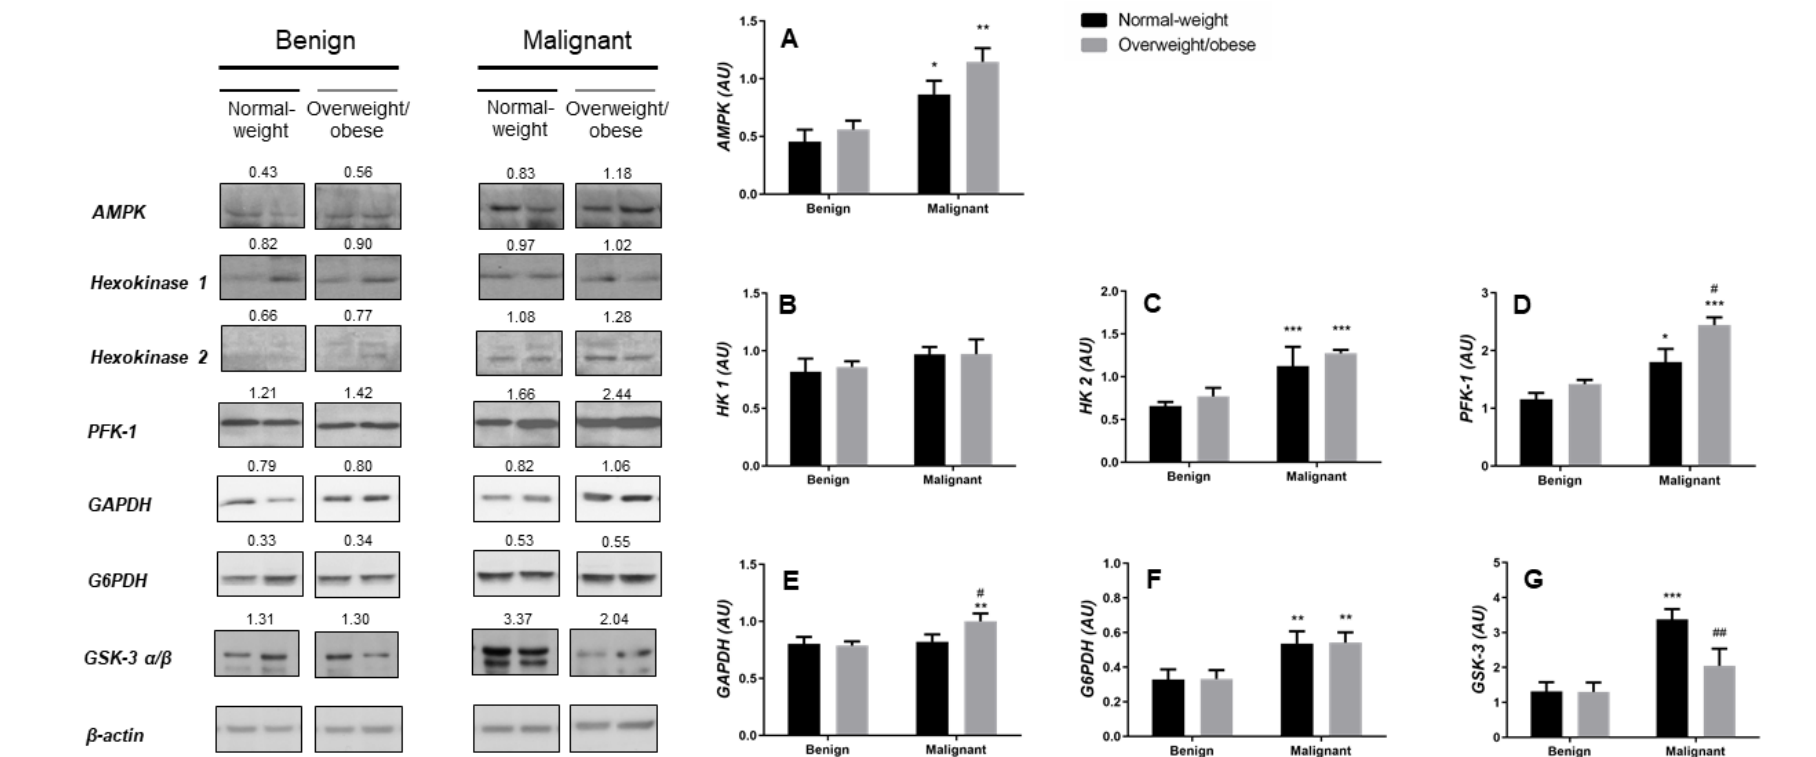
Figure 1. Breast cancer changes in glucose metabolic pathways and their relationship to obesity. Protein expression of 5′-AMP-activated protein kinase (AMPK, A ), hexokinase 1 (HK 1, B ), hexokinase 2 (HK 2, C ), phosphofructokinase (PFK-1, D ), glyceraldehyde-3-phosphate dehydrogenase (GAPDH, E ), glucose-6-phosphate 1-dehydrogenase (G6PDH, F ) and glycogen synthase kinase-3 (GSK-3 α / β , G ) in benign and malignant breast tumor tissue of normal-weight (black) and overweight/obese (gray) women. The protein content is normalized to β -actin levels and expressed in arbitrary units (AU); mean values of densitometric analysis for each group are shown above respective bands. Two representative band images cut from the same blot are shown for each group ( n = 9); each band is representative of three pooled samples. Images of whole uncut blots with values of densitometric analysis for each band are shown Figure S1. Bars represent average values ± S.E.M. * Comparison to respective benign counterpart, * p < 0.05, ** p < 0.01, *** p < 0.001. # Comparison to normal-weight malignant counterpart, # p < 0.05, ## p < 0.01.